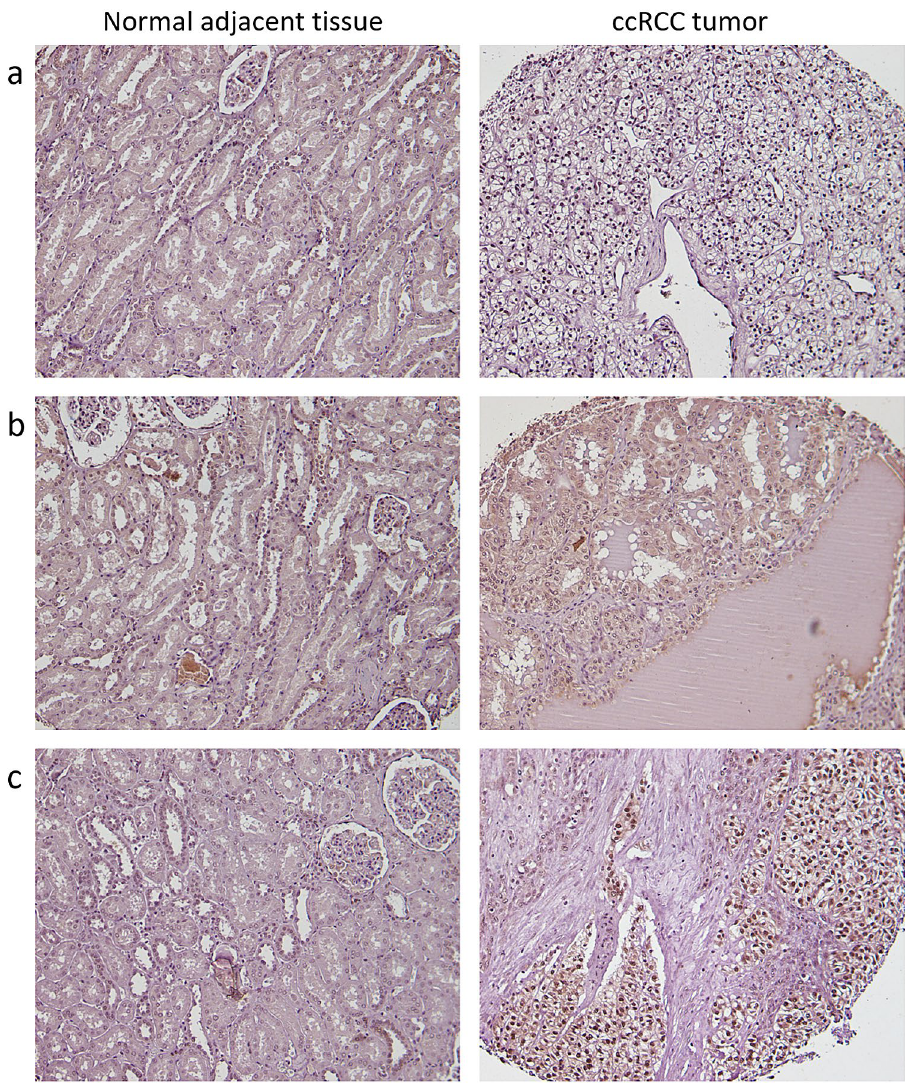
Figure 1. pS727-STAT3 location patterns in ccRCC tumors. Representative images of pS727-STAT3 immunohistochemical analysis showing normal counterparts (left panel) completely negative and tumor samples (right panel) exhibiting positive staining arranged in different location patterns: ( a ) only nuclear pS727- STAT3; ( b ) only cytosolic pS727-STAT3, and ( c ) nuclear and cytosolic pS727-STAT3. Original magnification × 200.